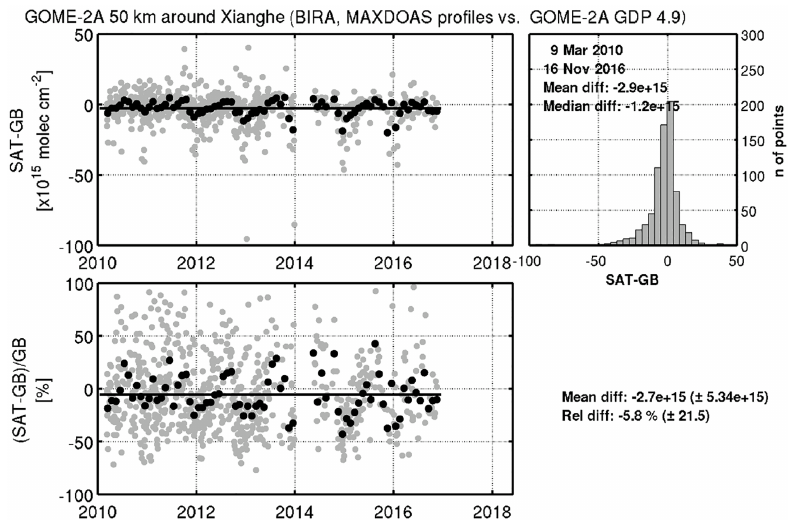
Figure 17. Daily (grey dots) and monthly mean (back dots) absolute and relative GOME-2A and MAXDOAS time series differences for the Xianghe station. The histogram of the daily differences is also given, with the mean and median difference, and the total time-series absolute and relative monthly differences are given outside the panels.